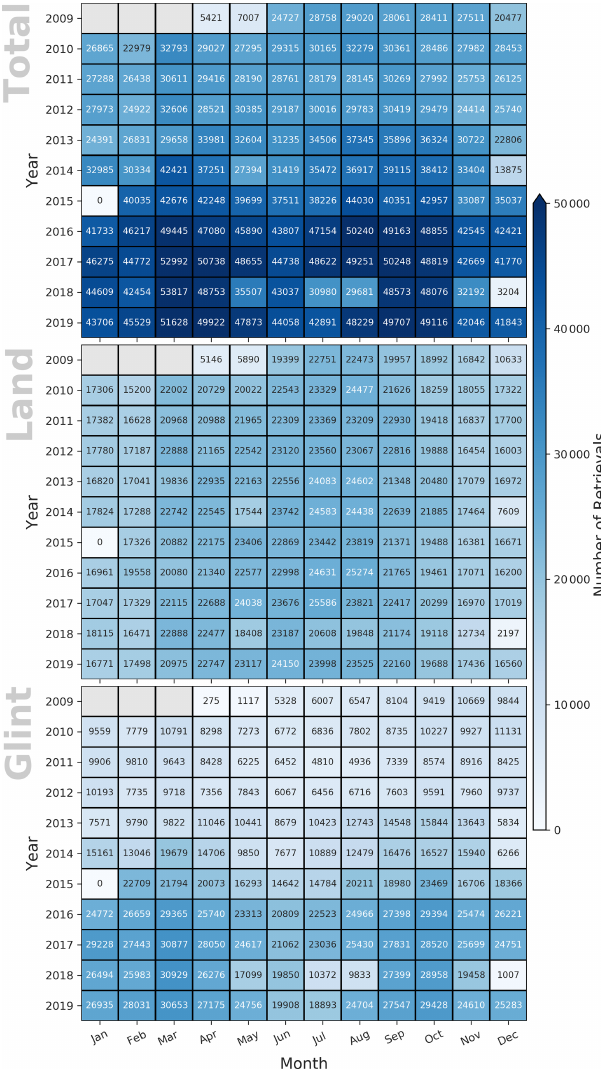
Figure 4. The number of GOSAT soundings per month in the final Proxy XCH 4 dataset, starting in April 2009 and ending in Decem- ber 2019. Counts are provided for the global total but also for land and glint observation modes